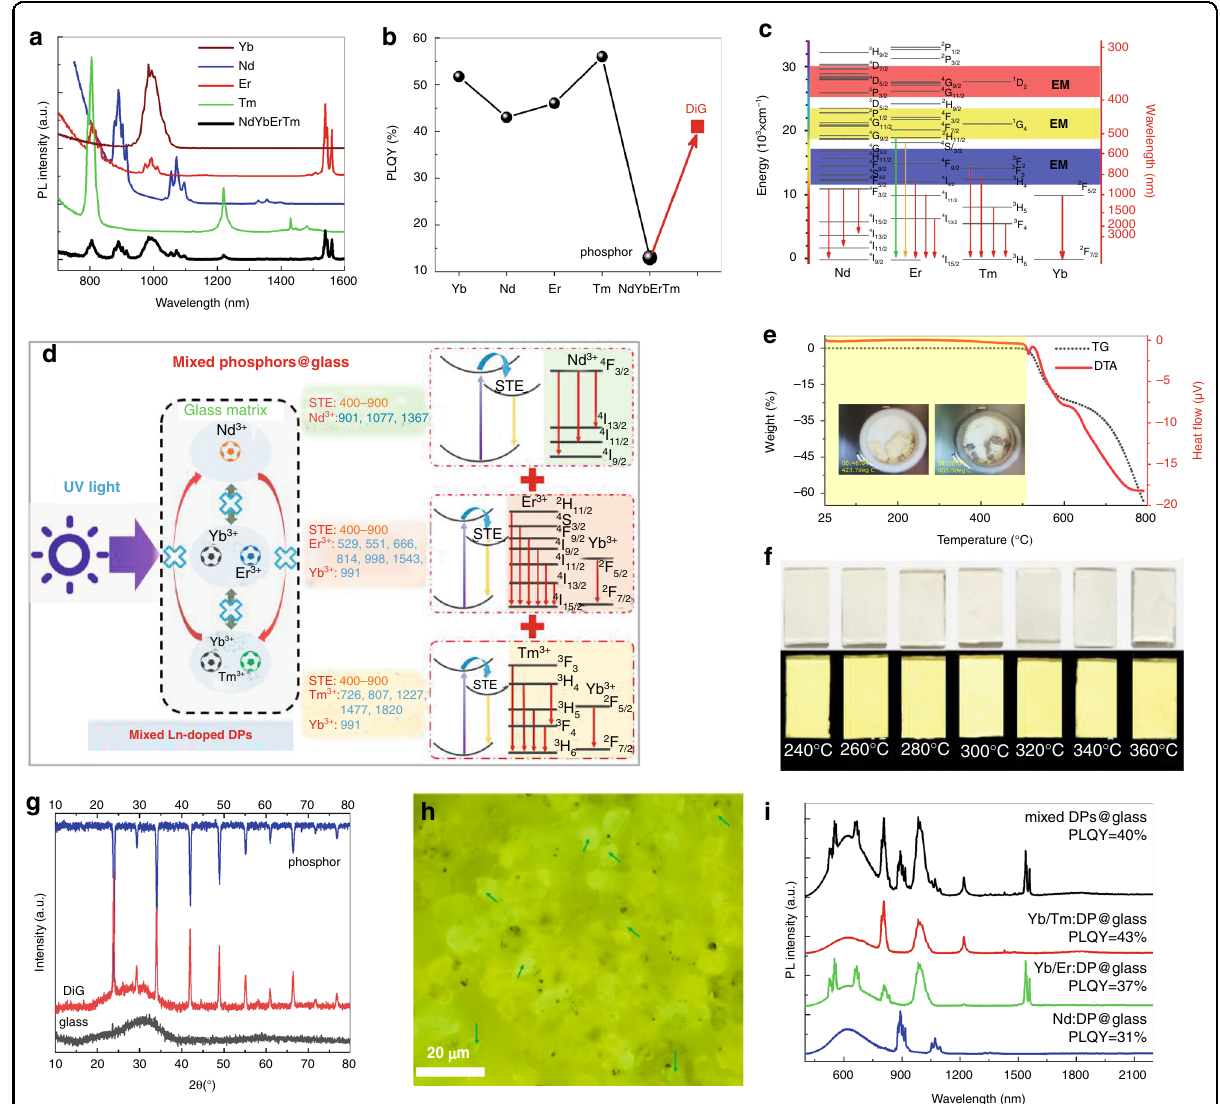
Fig. 3 Design of “ DP-in-glass ” composite and optimization of the related optical performance. a NIR PL spectra of the Yb, Nd, Er, or Tm single- doped samples and Yb/Nd/Er/Tm multidoped samples. b PLQYs of the corresponding fi ve samples and DiG composite. c Energy-level diagrams of the Nd, Er, Tm, and Yb activators, showing the consistent energy-migration (EM) levels (green, yellow, and blue regions), leading to coquenching PL. d Simpli fi ed schematic illustration of the heterogeneous architecture (DP-in-glass). e TG and DTA curves of a typical Bi/Er-doped sample. The insets are the samples sintered at 425 °C and 600 °C, respectively. f Photographs of Bi/Ln:Cs 2 AgInCl 6 – DiG – SA composites prepared with different sintering temperatures excited by daylight (top) and UV light (bottom). g XRD patterns of the DP phosphor, the blank glass, and the DiG composite. h Fluorescence image of DiG under UV-light excitation. i PL spectra of different kinds of